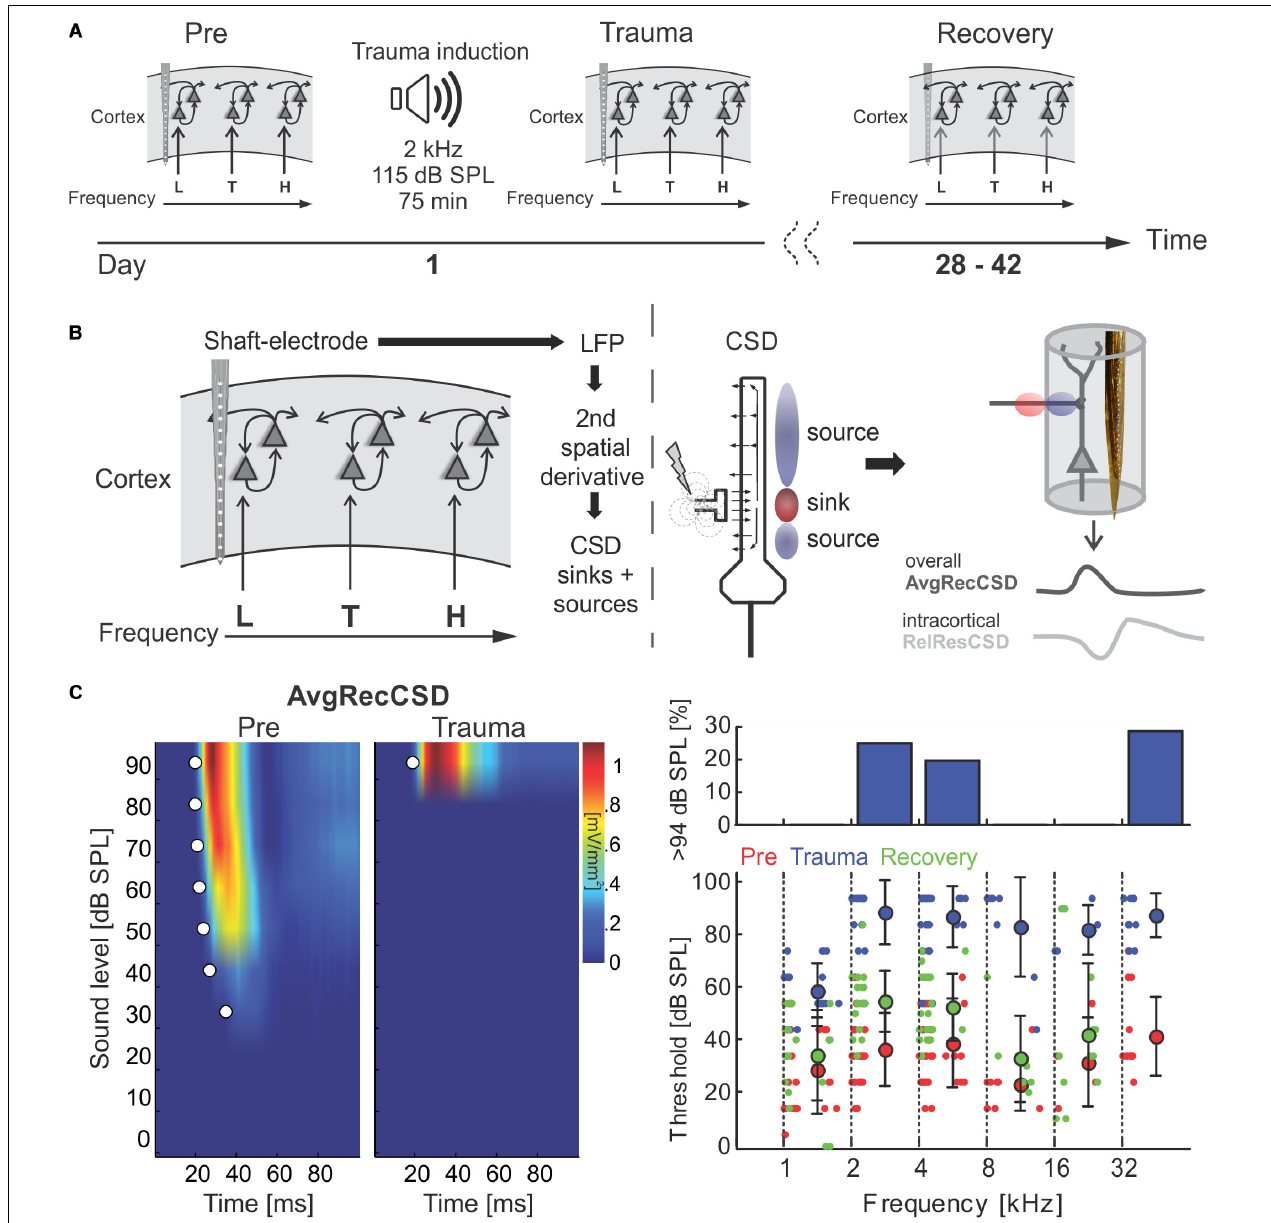
FIGURE 1 | (A) Schematic representation of the timeline of experiments investigating sound trauma related effects in the auditory cortex. Electrophysiological recordings were obtained directly before ( Pre ) and after trauma ( Trauma ) as well as after 4 to 6 weeks ( Recovery ). The schematics symbolize a piece of auditory cortex with an inserted shaft electrode and tonotopic locations corresponding to the trauma frequency (T) as well as lower (L) and higher frequencies (H). (B) Schematic of data analysis strategy (see main text for further explanation). (C) Analysis of significant AvgRecCSD responses to investigate sound trauma related effects on cortical response thresholds. A representative example (left panel) depicts the AvgRecCSD (heat map coded; warm colors correspond to larger AvgRecCSD values; significant responses are indicated by white circles) in response to presentations of 2 kHz tones and illustrates the increase in threshold from 34 dB SPL to 94 dB SPL following trauma induction. Thresholds determined in the population data were plotted for different frequency bins and time points relative to trauma (right bottom panel). Immediately after trauma induction (blue circles) a threshold could not be determined in a number of cases (right top panel). Four to 6 weeks after trauma thresholds (green circles) recovered to a large